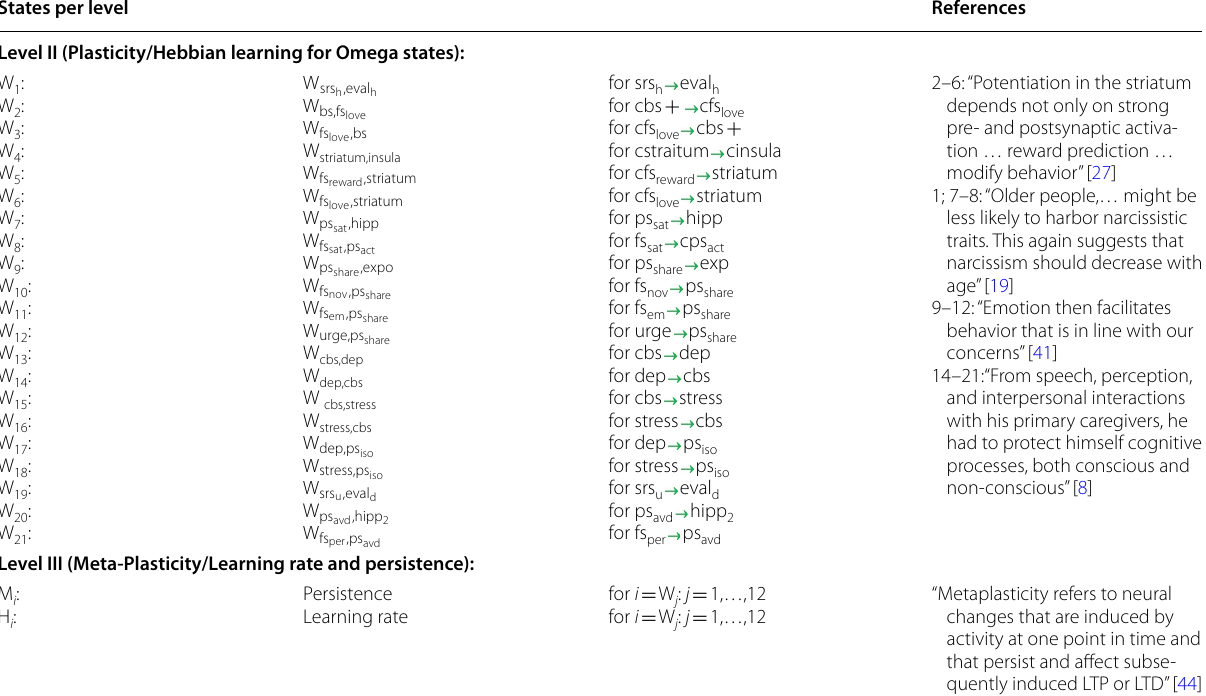
Table 2 Explanation of states in level II and III States per